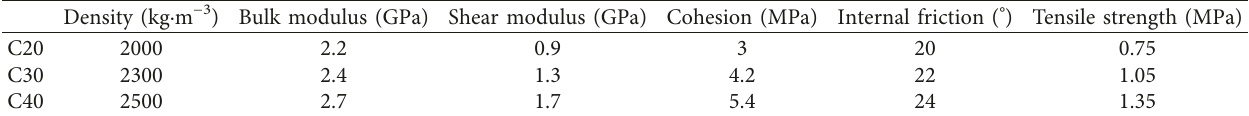
Table 5: Parameters for backfilling wall materials.